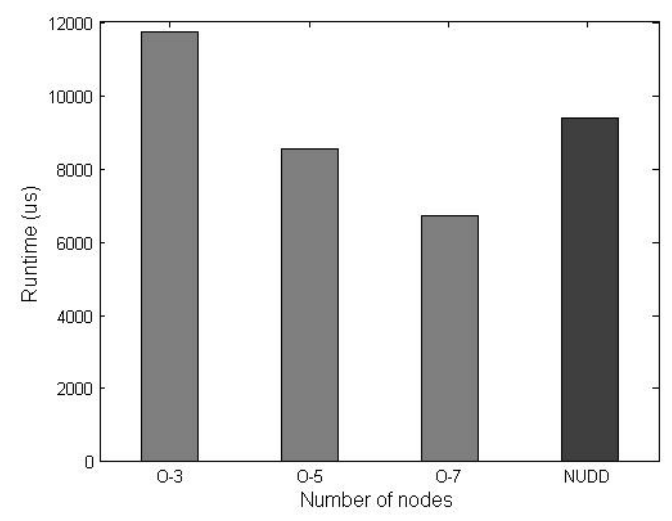
Figure 6. The number of subdomains was set to 9.